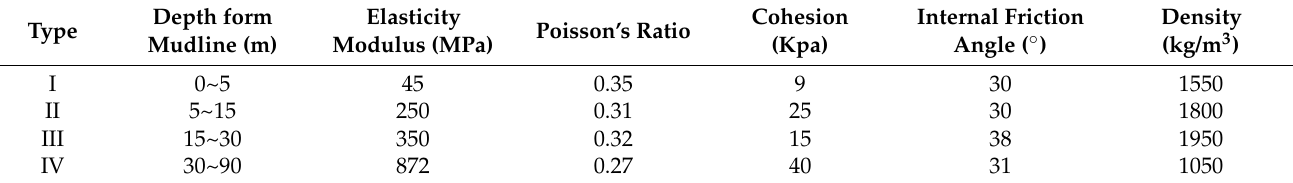
Table 2. Soil parameters.